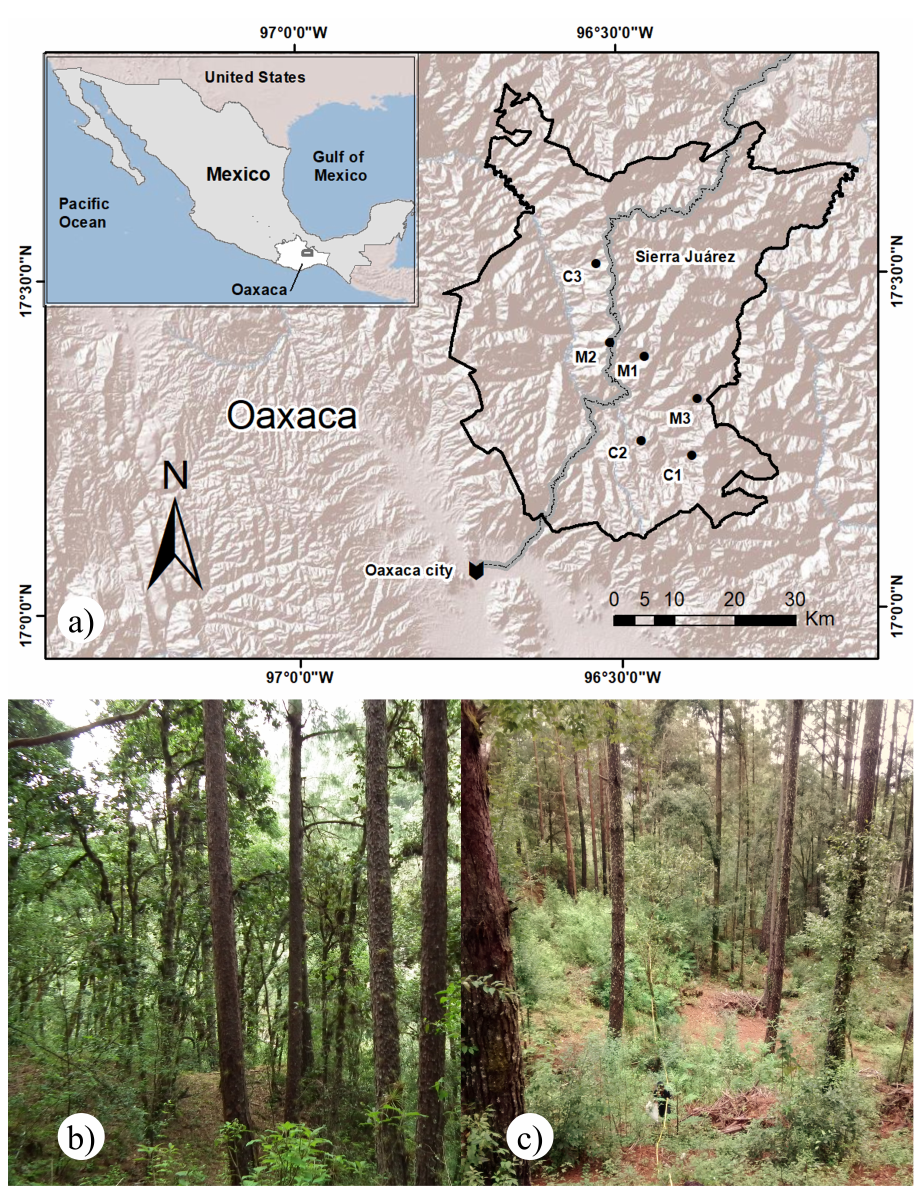
Figure 1. ( a ) Study sites in Sierra Ju á rez, Oaxaca (black circles). Conserved sites: Santa Mar í a Yaves í a (C1), Santa Catarina Lachatao (C2), and San Juan Luvina (C3). Managed sites: Ixtl á n de Ju á rez (M1), San Juan Evangelista Analco (M2), and Capul á lpam de M é ndez (M3). Stitch line is the road 175 Oaxaca-Tuxtepec. ( b ) Examples of conservation (C1) and ( c ) management (M2)